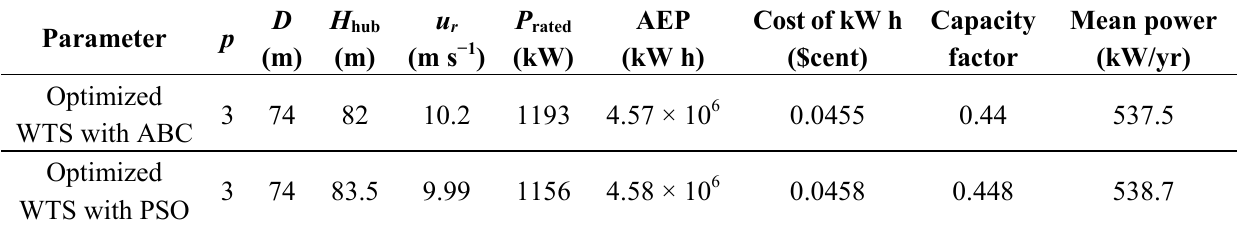
Table 5. Optimized parameters and performances of fixed-speed WTSs for Northern